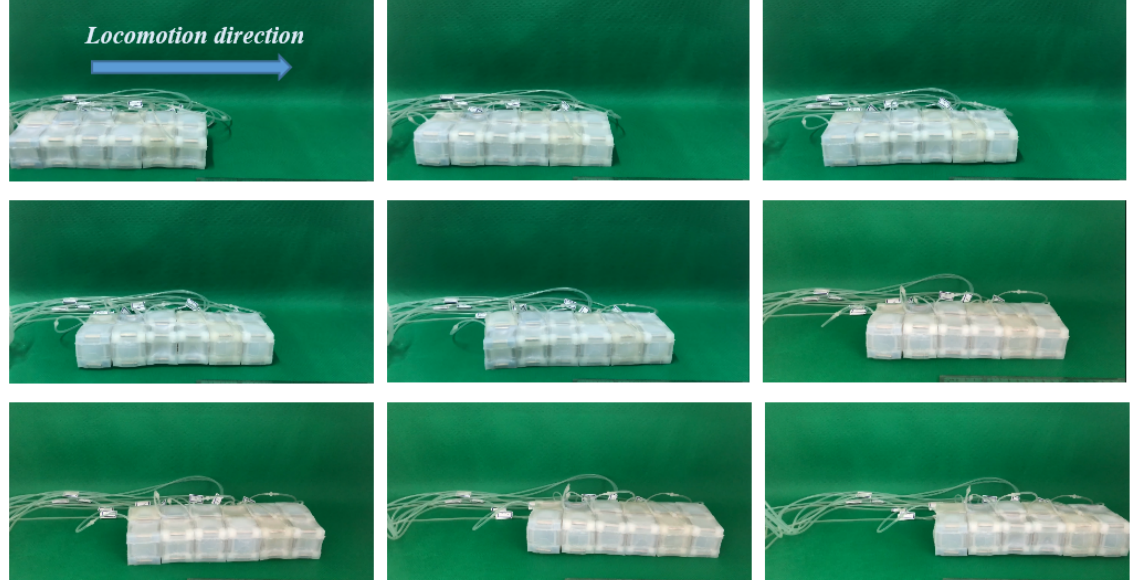
Figure 13. Locomotion Process of snake configuration in the real